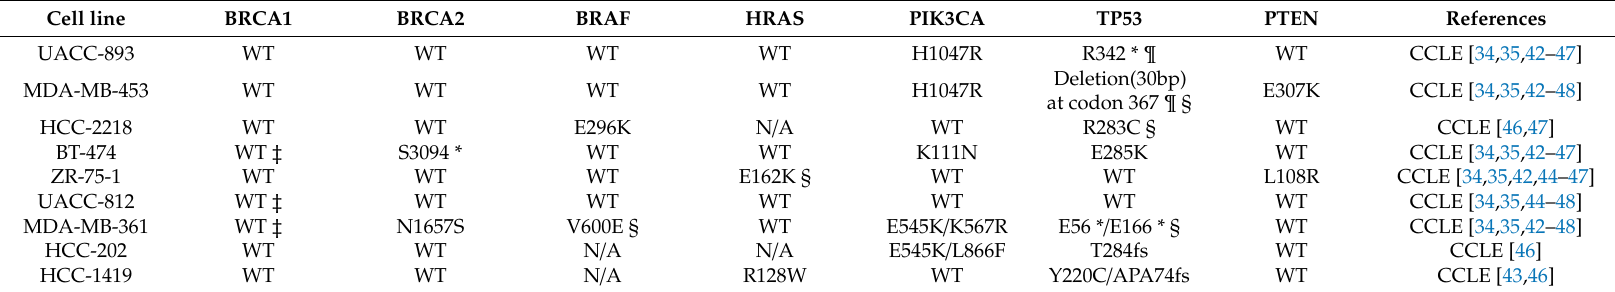
Table 2. Gene Mutation Profile of Nine HER2-positive Breast Cancer Cell